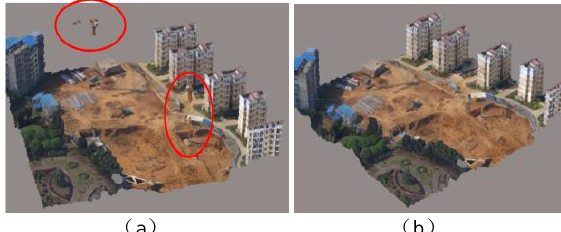
Fig 15. Editing of suspended objects(a) before, (b) after.